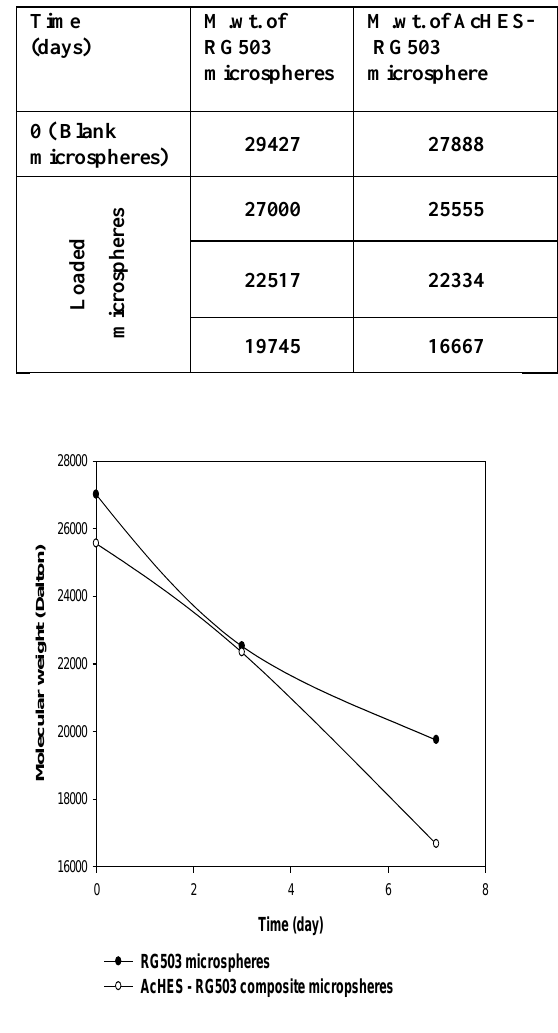
Figure 3:The molecular weight of 10%KSL peptide loaded microspheres before and after incubation in 0.1M phosphate buffer saline, pH 7.4 at